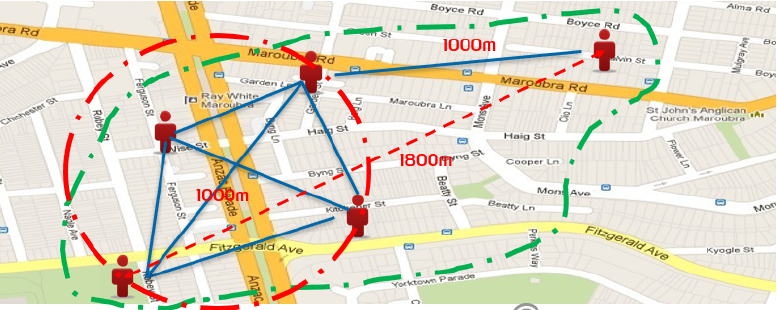
Figure 2. Illustration of the comparison between our model definition and that of Yao et al. [8]. Formally speaking, given a network G = ( V , E ) and parameters (cid:101) , µ , γ , where each vertex v carries location coordinates ( v . x , v . y ) , a GSG is a set C of vertices such that (1) ( structurally cohesive ) the subgraph G [ C ] of G induced by C is a structural graph cluster under (cid:101) and µ and (2) ( spatially cohesive ) vertices in C are all within a maximum minimum covering circle ( MCC ) for which the radius is no greater than a distance threshold γ .